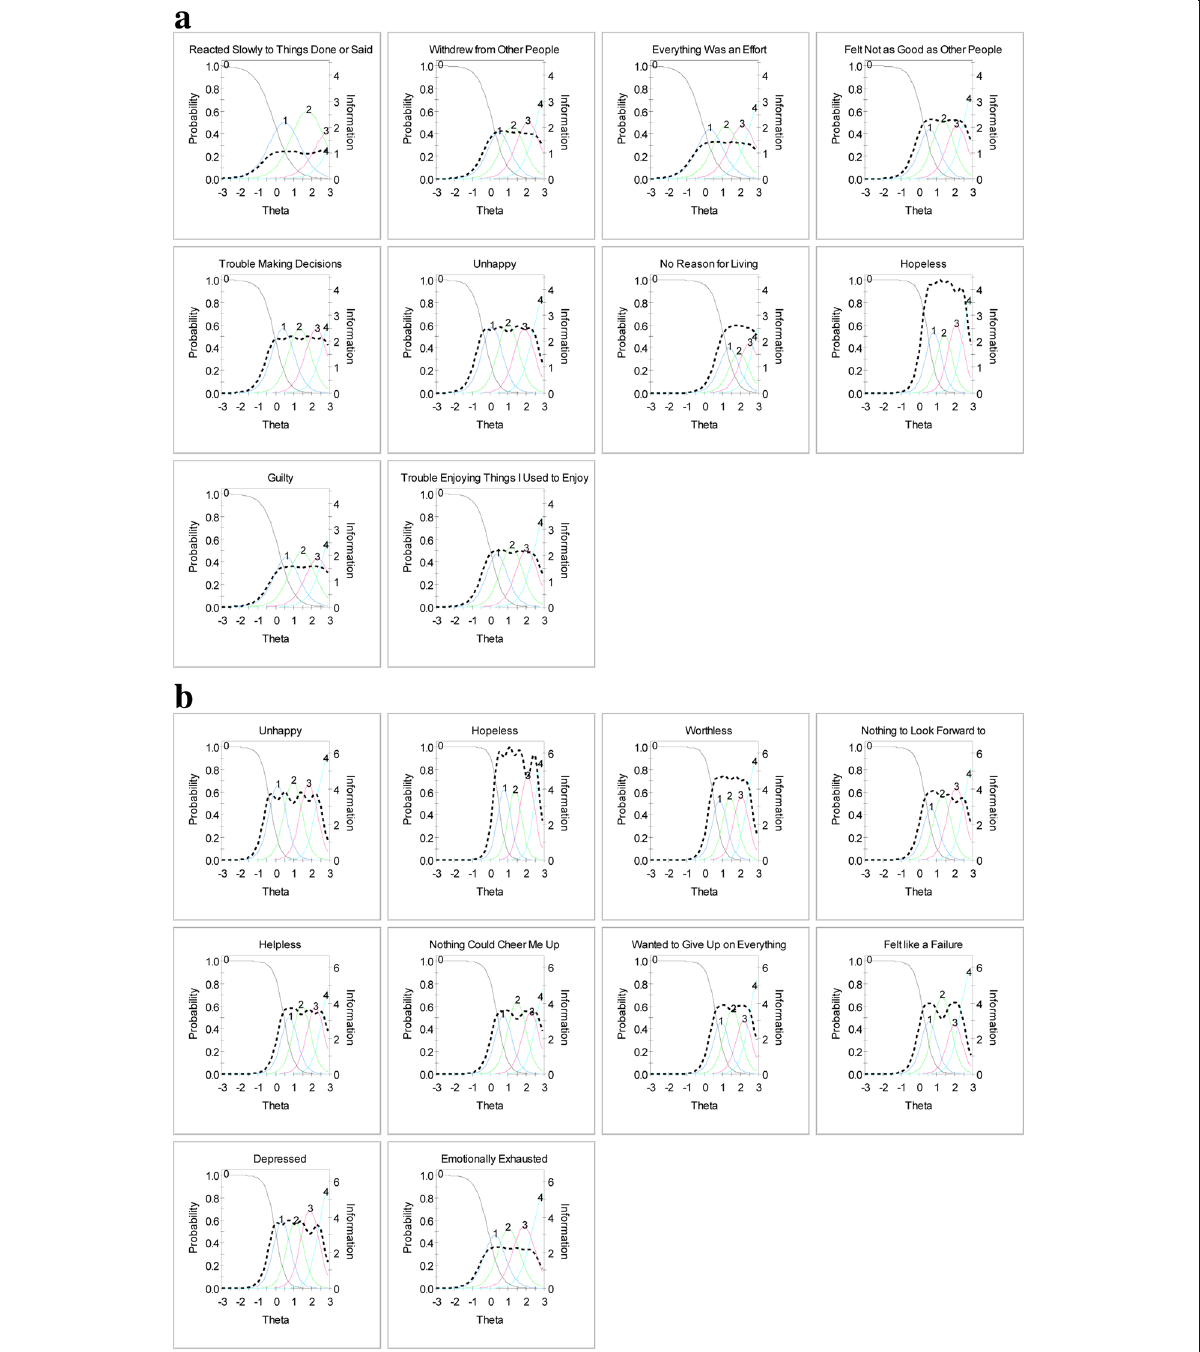
Fig. 4 Item characteristic curves and information curves for items in a Short Form 1 b Short Form 2. Solid lines: item characteristic curves; dotted lines: information